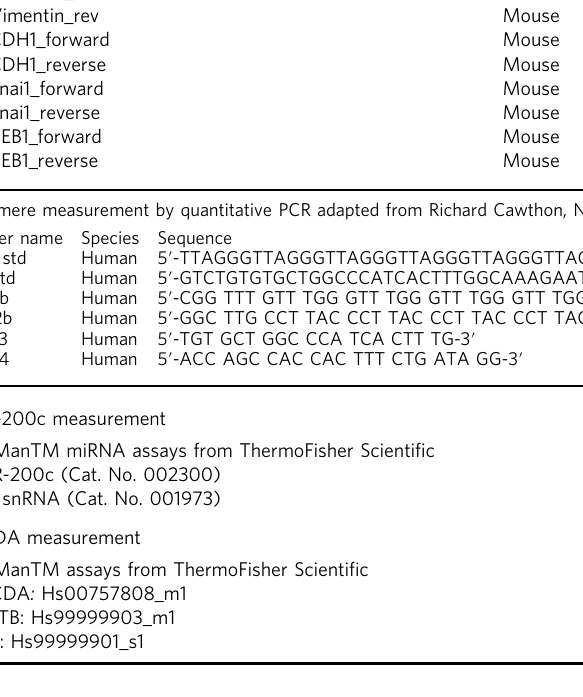
Table 1 Primers and TaqMan assays used for validation. Measurement of candidate genes involved in the EMT process for the serial TCL1A mouse transplant model